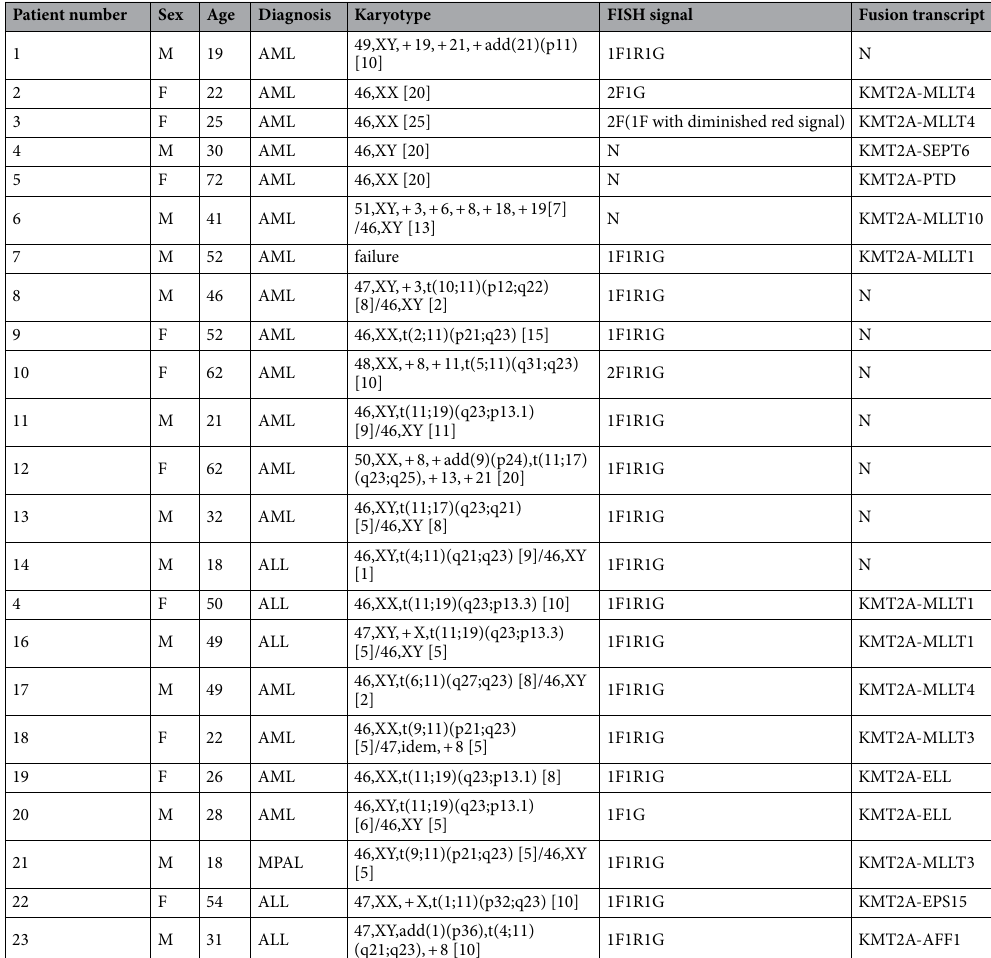
Table 2. Clinical, cytogenetic and molecular results of 23 patients with KMT2A rearrangements. F female, M male, ALL acute lymphoid leukemia, AML acute myeloid leukemia, MPAL mixed-phenotype acute leukemia, N